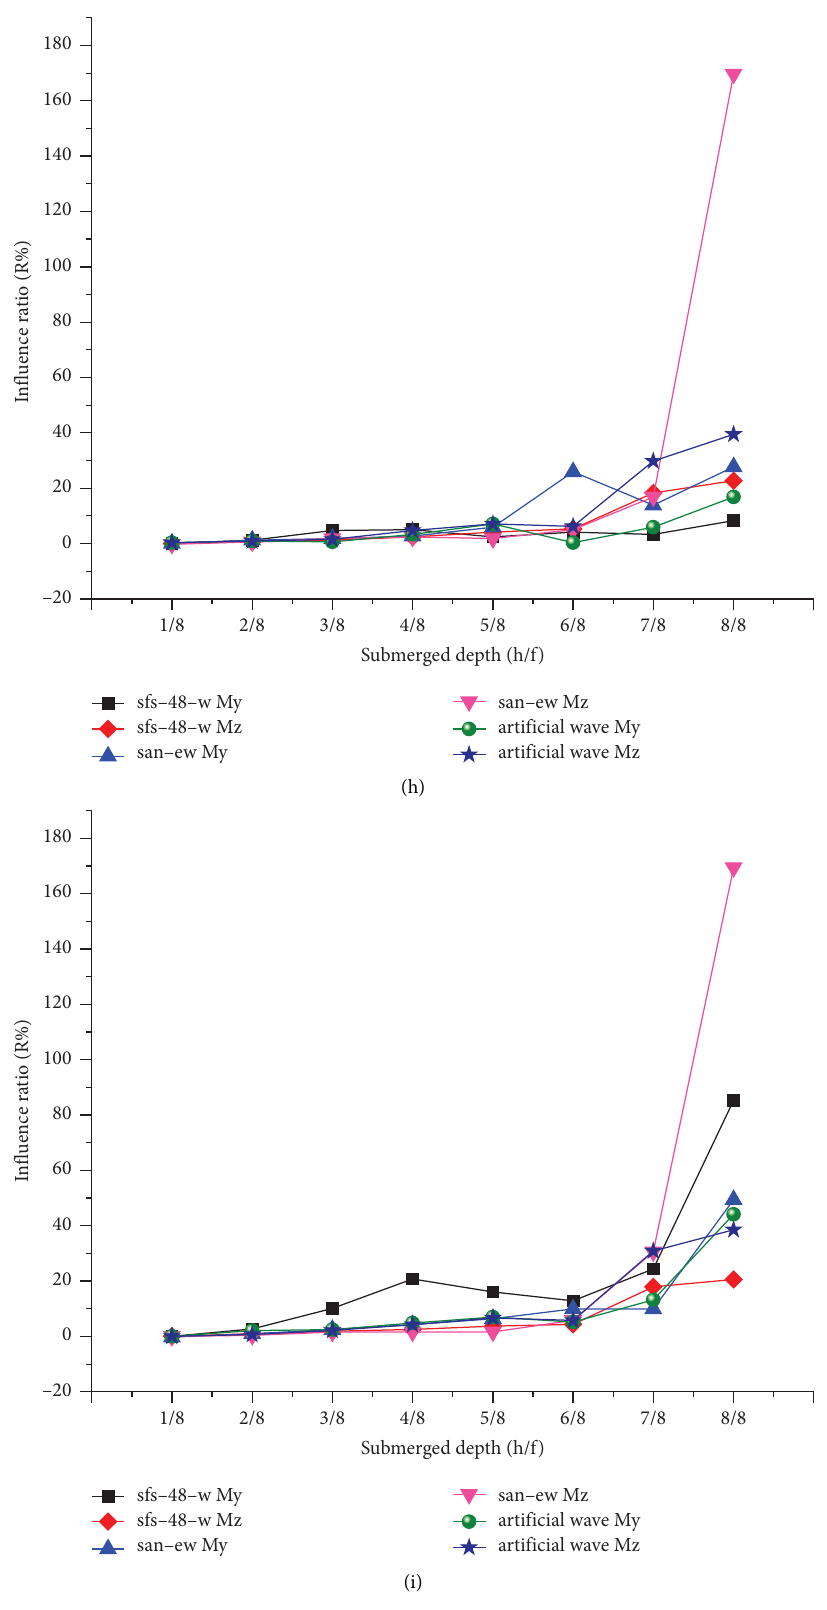
Figure 7: Te relation of R and submerged depth at diferent positions of the main arch. (a) Te relation of R and submerged depth at arch foot. (b) Te relation of R and submerged depth at L/16 of the arch. (c) Te relation of R and submerged depth at 2L/16 of the arch. (d) Te relation of R and submerged depth at 3L/16 of the arch. (e) Te relation of R and submerged depth at 4L/16 of the arch. (f) Te relation of R and submerged depth at 5L/16 of the arch. (g) Te relation of R and submerged depth at 6L/16 of the arch. (h) Te relation of R and submerged depth at 7L/16 of the arch. (i) Te relation of R and submerged depth at the vault